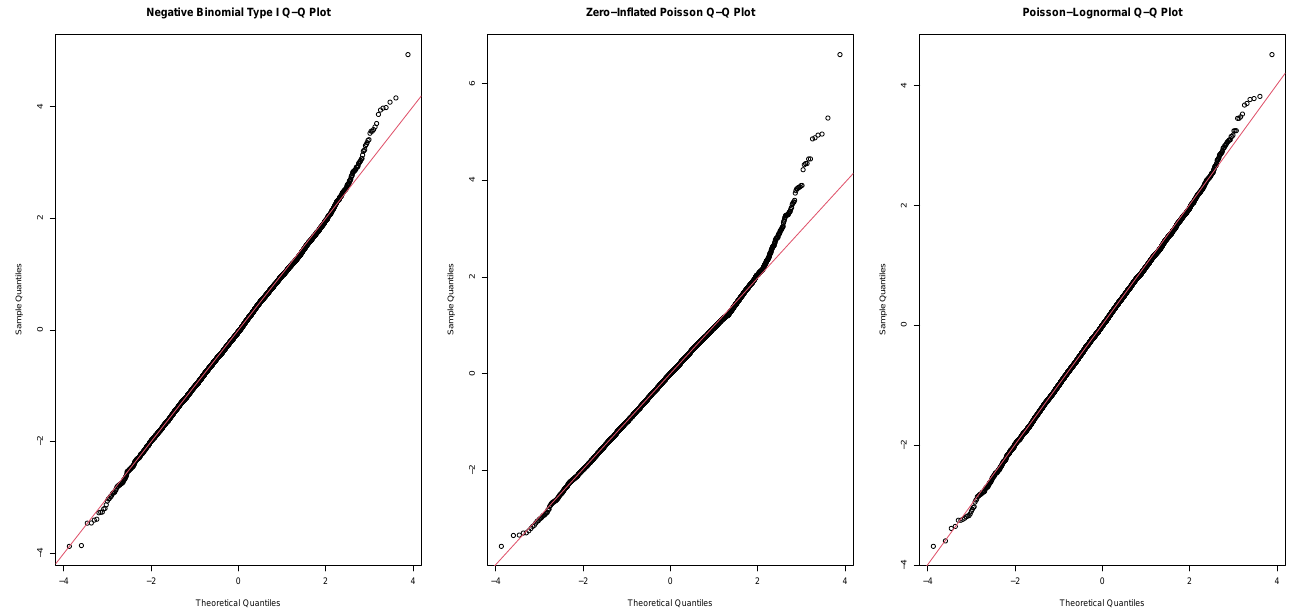
Figure 1. Normalized quantiles for the ZIP regression model and the NBI and PLN regression models with varying